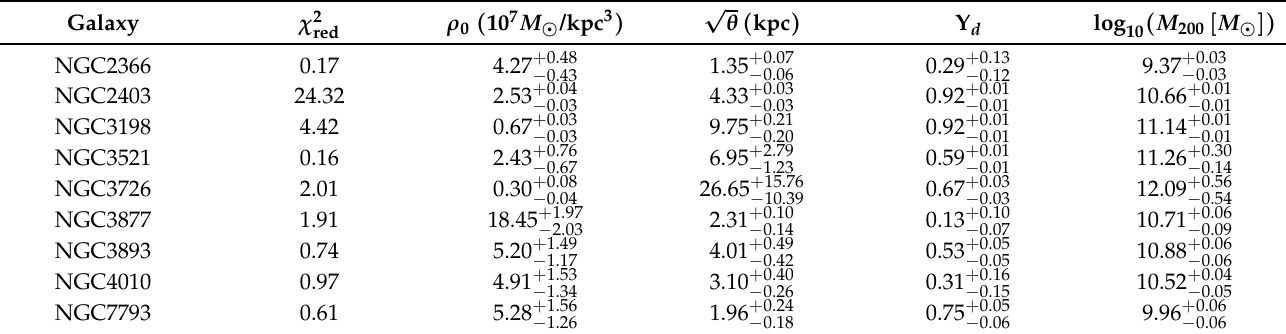
Table 1. For Noncommutative-like (NC) model, from left to right: Name of low surface brightness (LSB) galaxies of the Spitzer Photometry and Accurate Rotation Curves (SPARC), the reduced χ 2 , energy density, the DM mass within a radius r 200 which the density is ρ 200 ( r 200 ) (200 times the critical density of the universe).